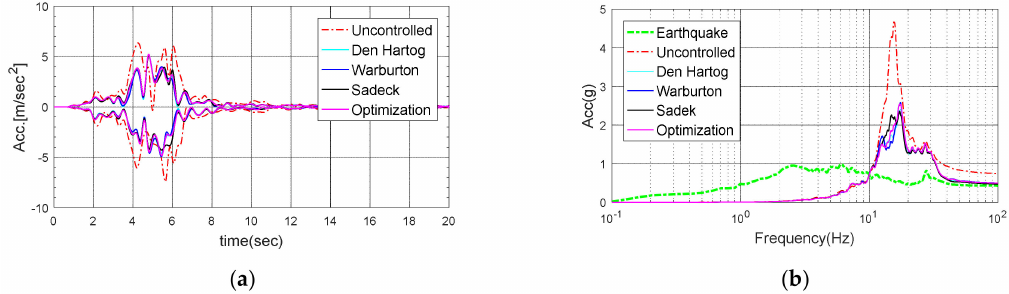
Figure 26. Response of the electrical cabinet subjected to Friuli: ( a ) Time history; ( b ) Response spectrum.